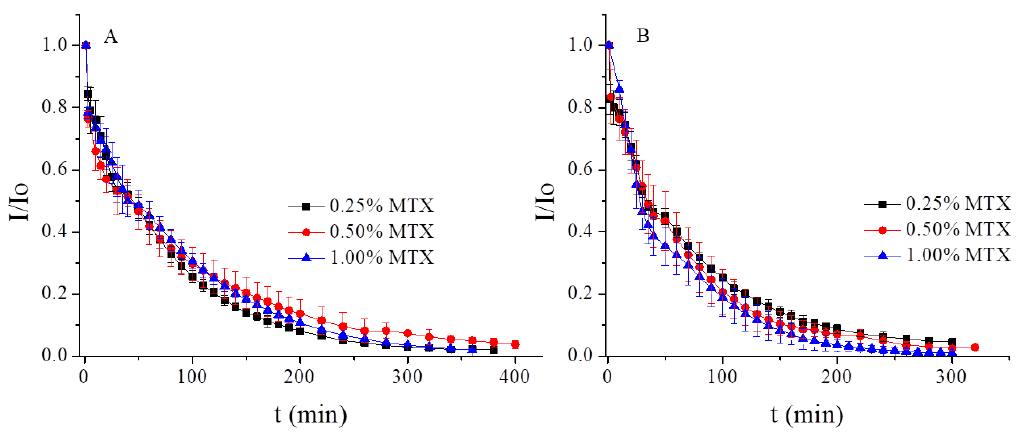
Figure 4. Release profile of MTX from LCPs at pH 7.4 at 25 °C ( A ) and 37 °C ( B ).